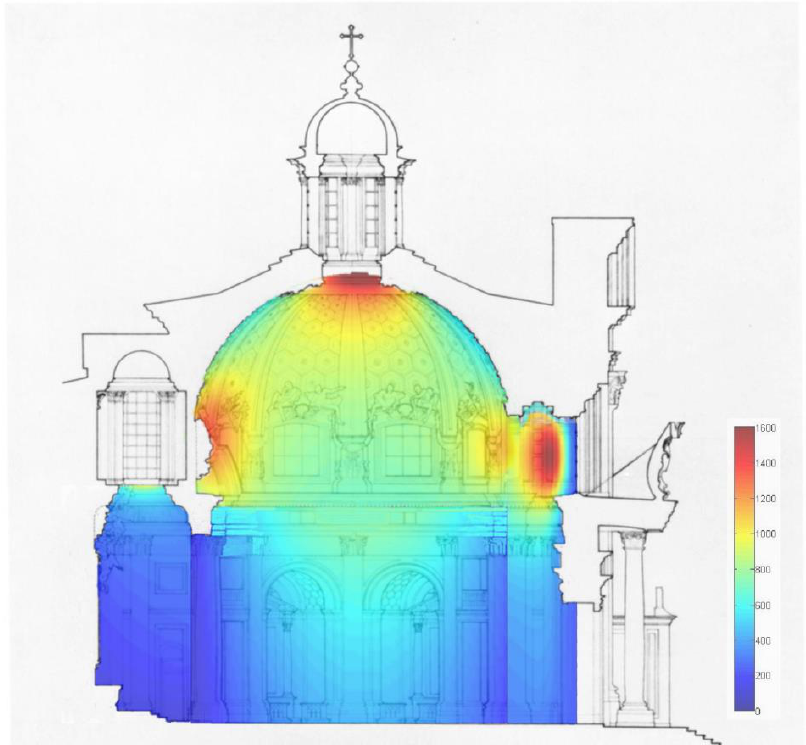
Figure 9. Daylight Section of the Sant’Andrea Church , showing the subtle behaviour of the niche chapel. niche chapel.